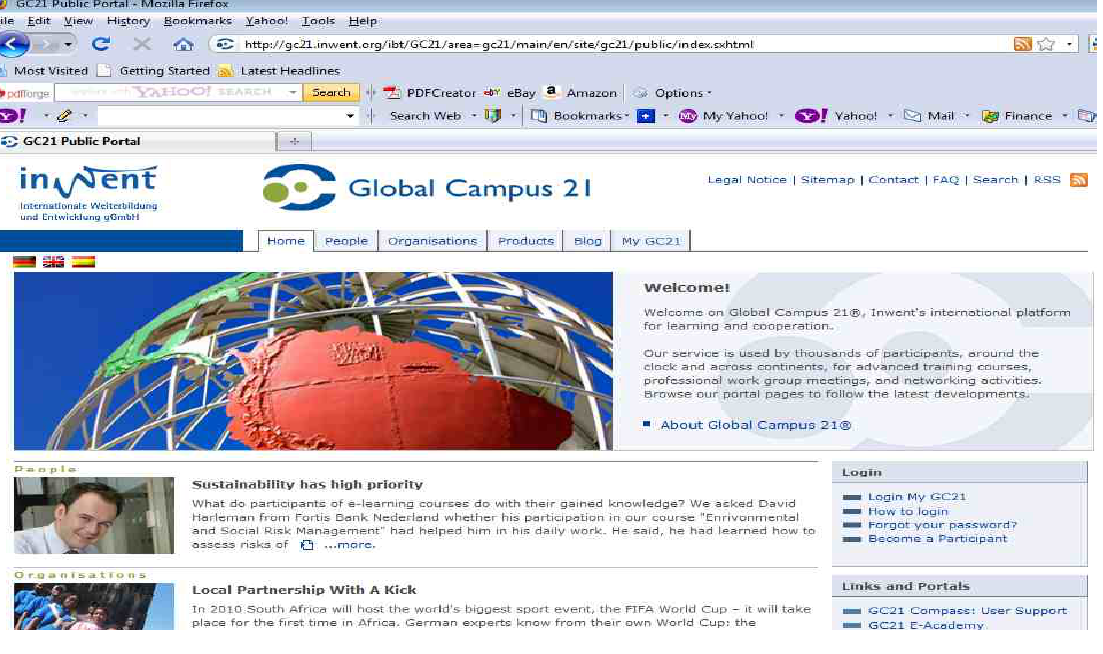
Figure 2: Global Campus 21